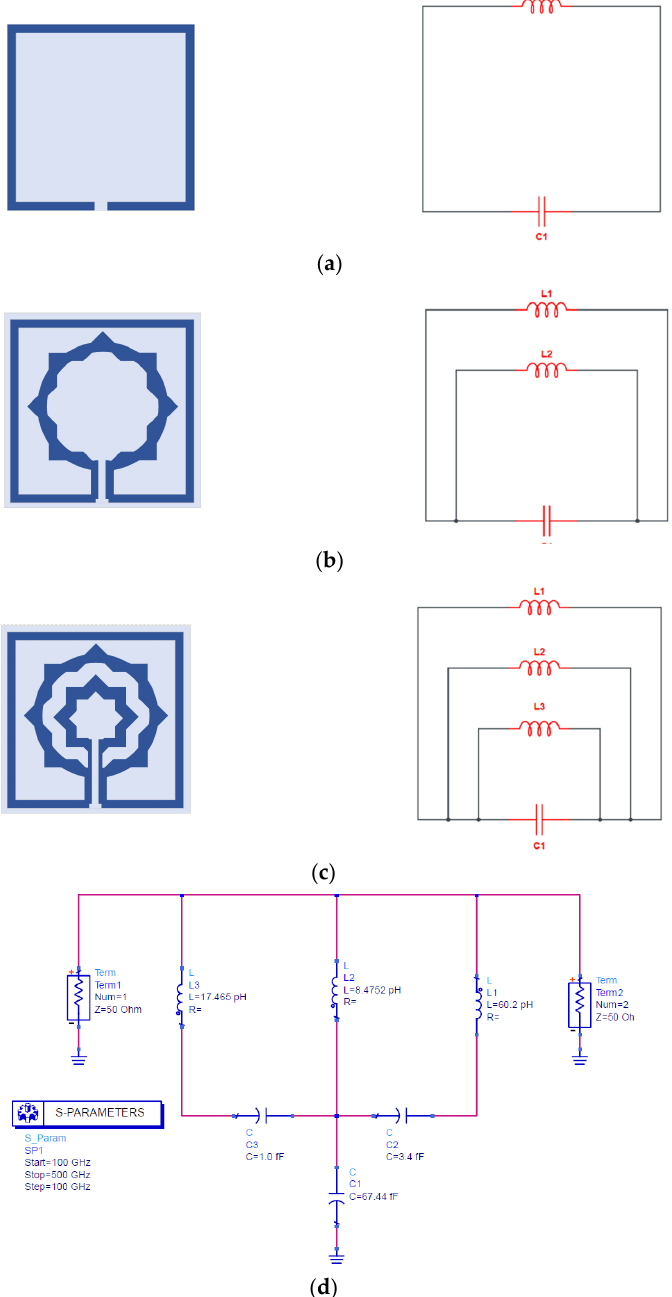
Figure 5. Equivalent circuit model: ( a ) single split-ring resonator; ( b ) two split-ring resonators; ( c ) three split-ring resonators; ( d ) final obtained equivalent circuit model.